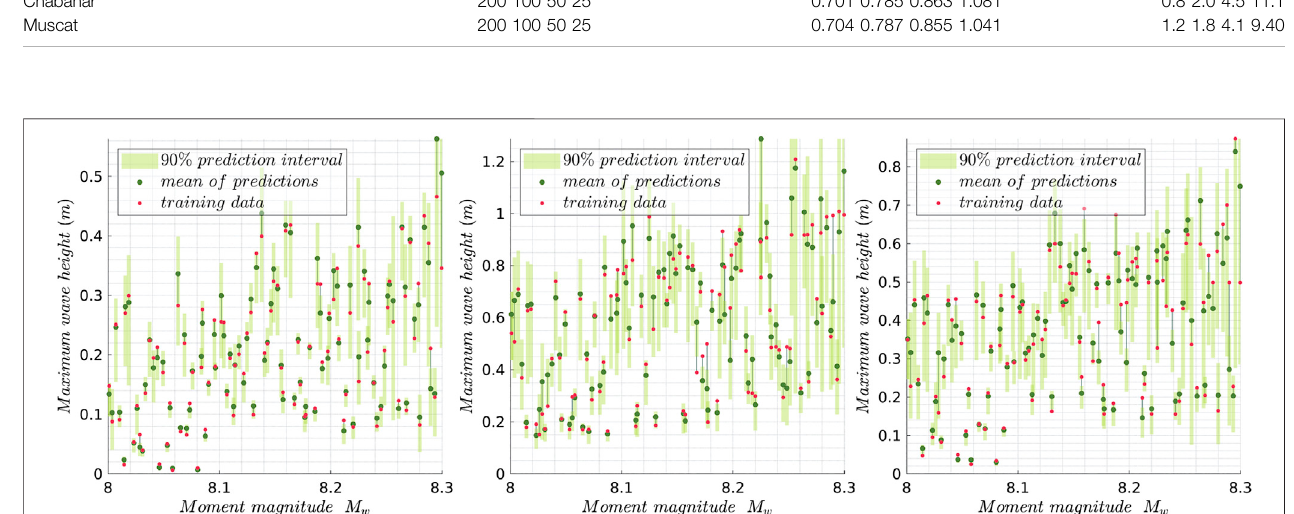
FIGURE 5 | Leave-One-Out diagnostics for a gauge in Muscat (left) , Karachi (middle) , and Chabahar (right) . The discrepancies between the training set and the predictions are shown by the vertical line segments